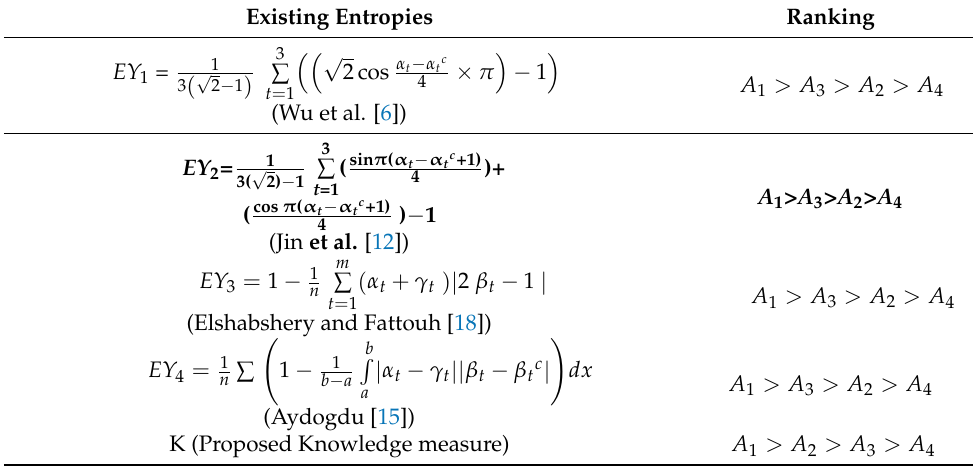
Table 10. Ranking result using existing entropies and the proposed knowledge